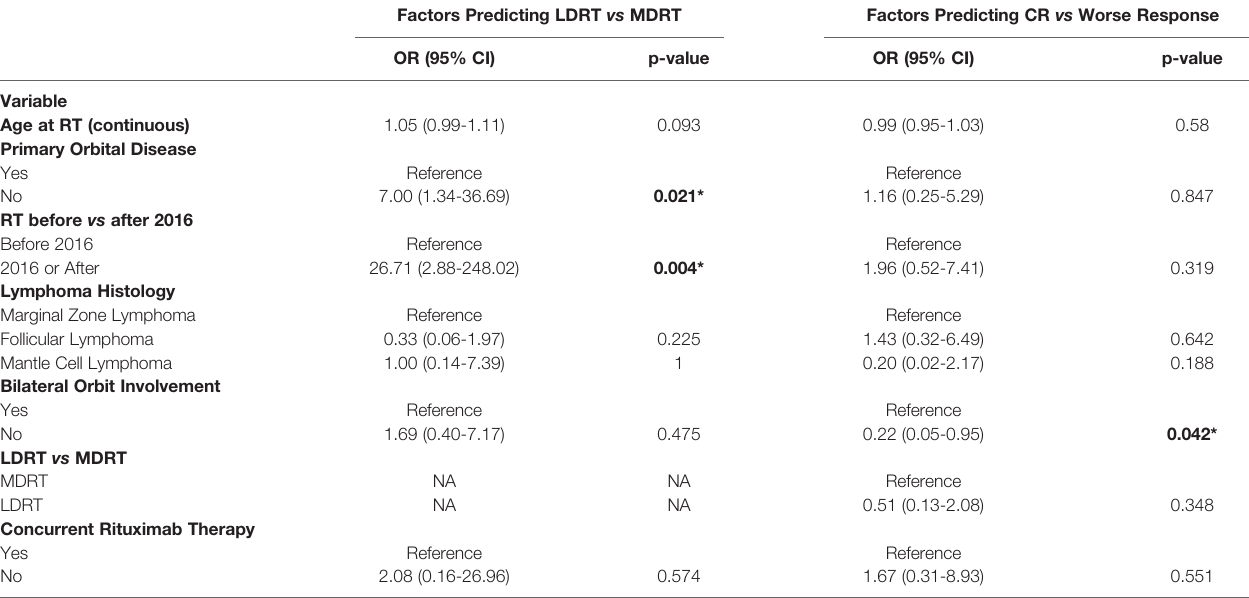
TABLE 2 | Univariate logistic regression for factors predicting use of LDRT vs MDRT and for factors predicting CR vs Worse